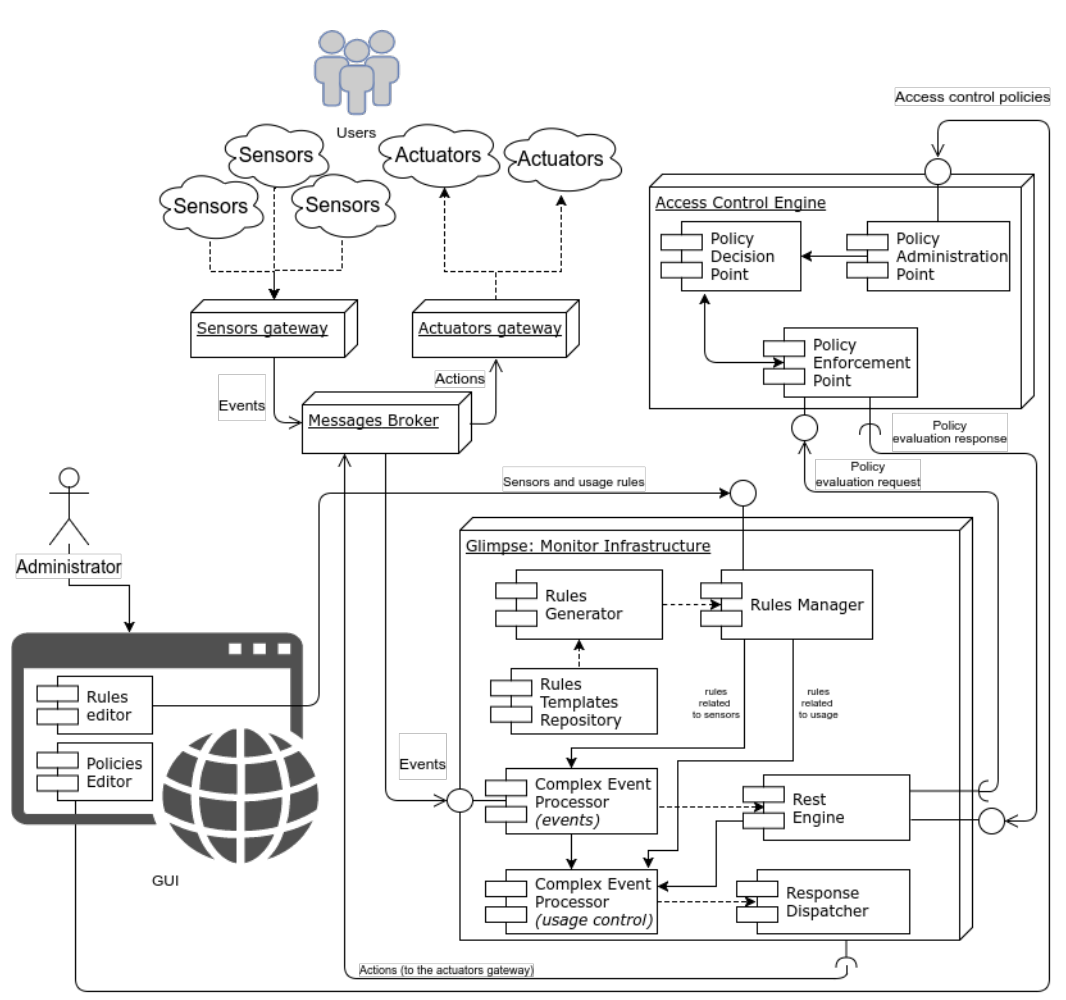
Figure 3. Proposed